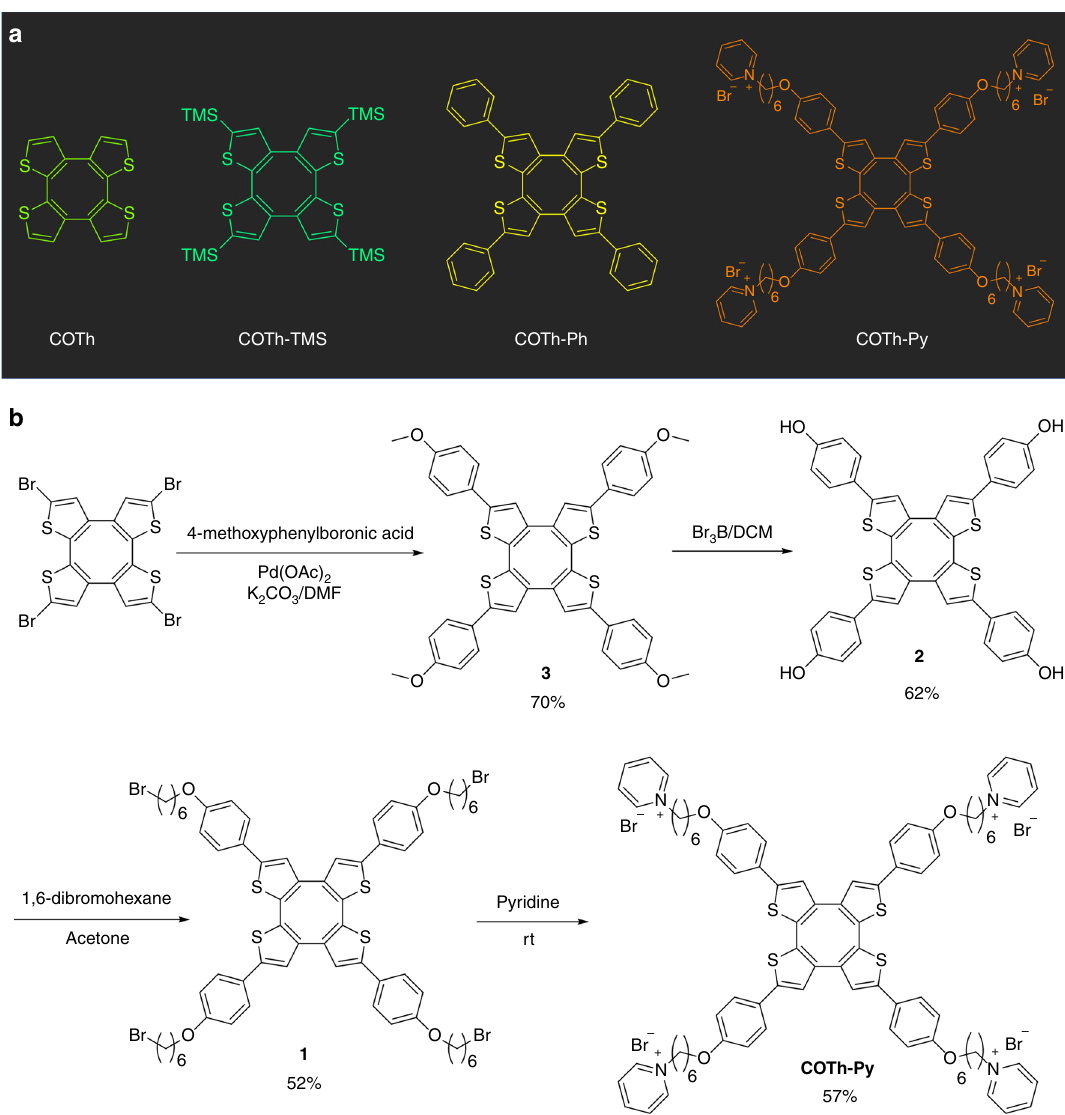
Fig. 2 Structures and synthetic routes. a Structure of COTh and its derivatives. b The synthetic route to